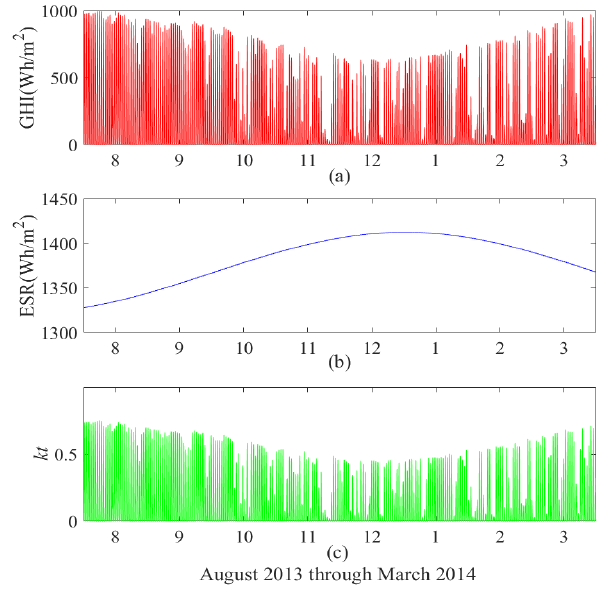
Figure 1. Eight months solar irradiance data set used in naïve Bayes (NB) model: ( a ) Hourly actual global horizontal irradiance (GHI); ( b ) normalization factor extraterrestrial solar radiation (ESR); ( c ) clear index kt .